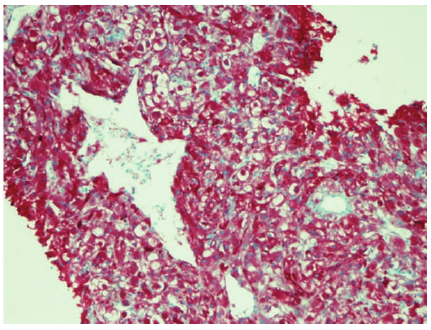
Figure 5: Melan-A stain.